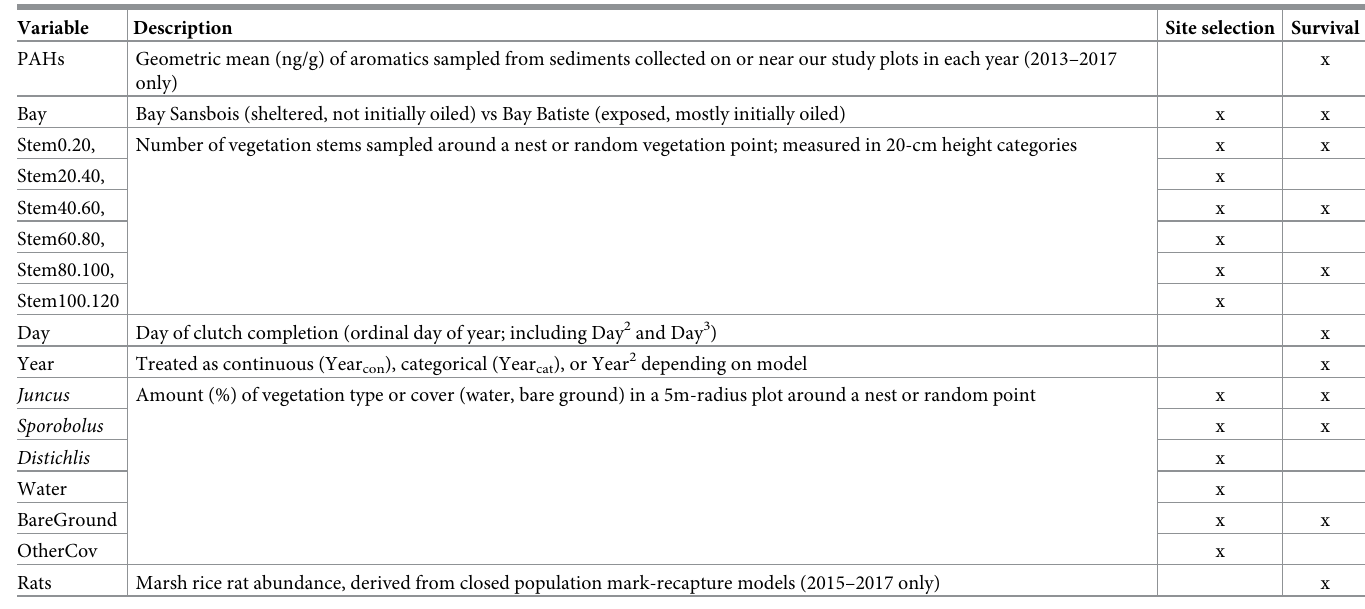
Table 1. Description of variables considered for Seaside Sparrow nest site selection and nest survival models in Louisiana,